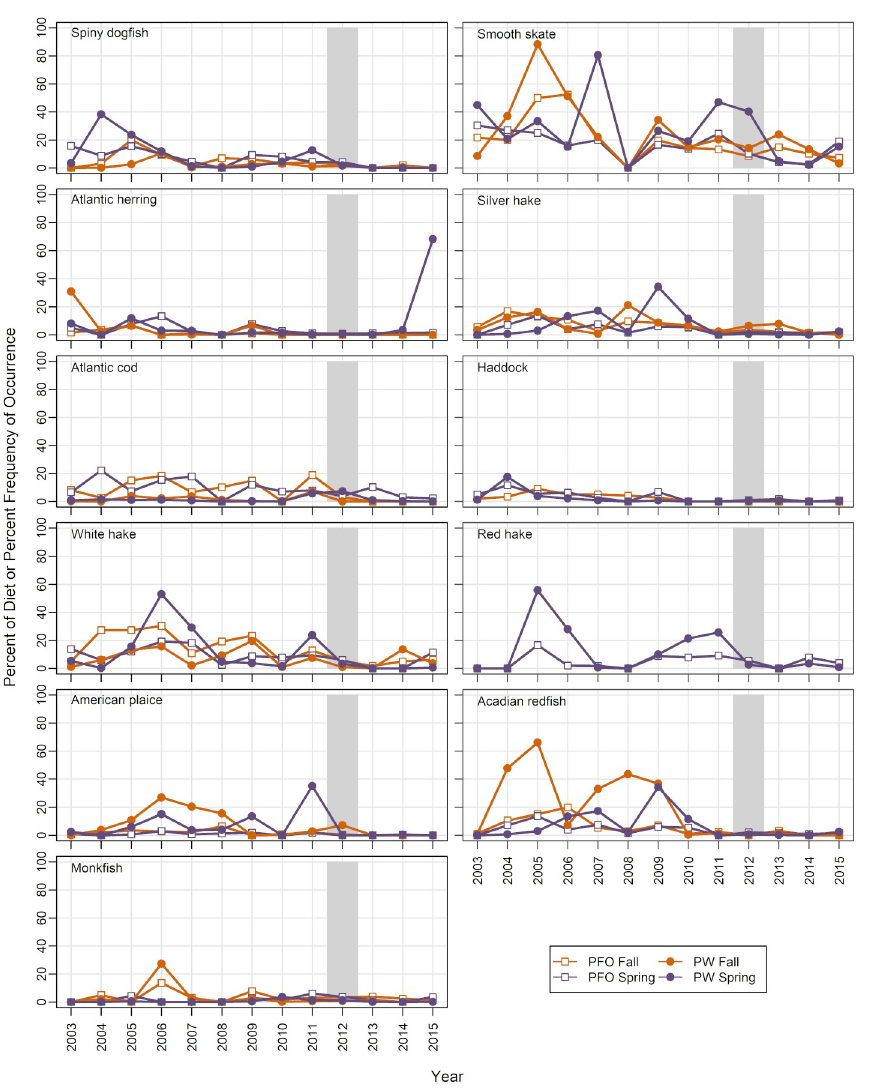
Fig 8. Percent frequency of occurrence and percent by weight of Pandalid shrimp in fish predator stomachs. Food habits data were collected in offshore spring and fall surveys. Shaded bar highlights 2012, when the shrimp decline became